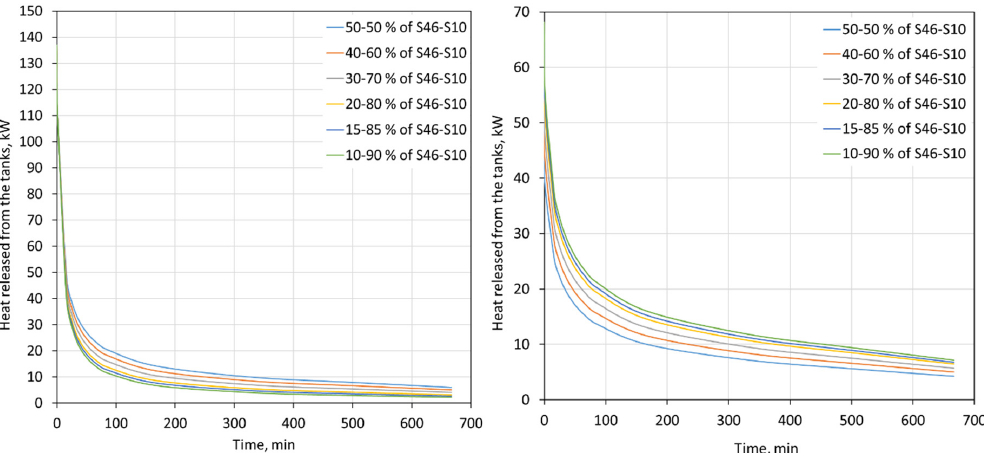
Figure 9. Heat flux released from two 2000-L tanks for a 7 kg/s water mass flow rate for the heating (left) and cooling (right) modes for different proportions of S46 and S10.